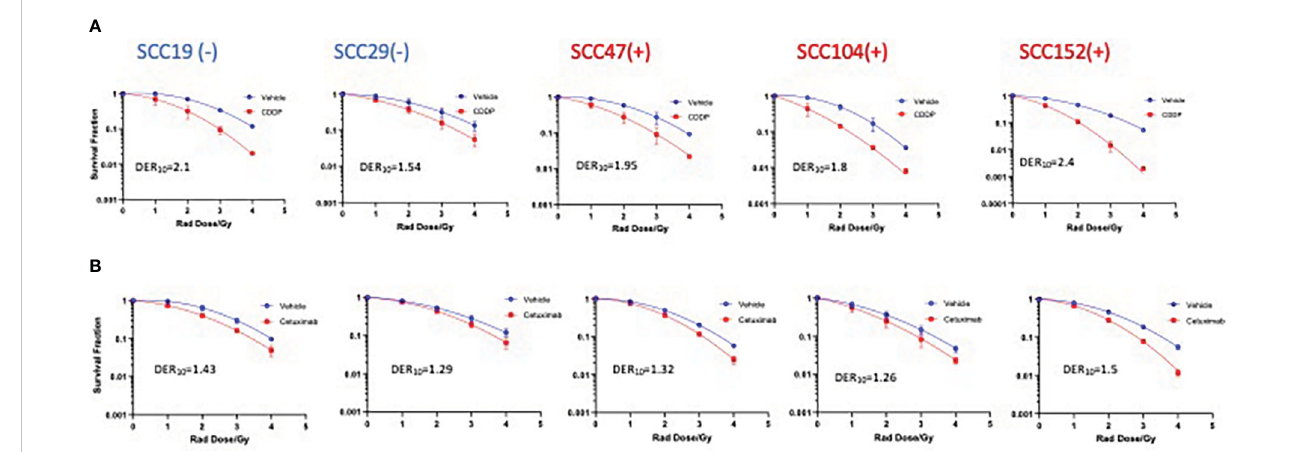
FIGURE 1 Sensitization of HNSCC cells to X-ray radiation combined with CDDP and Cetuximab. HPV - (-) and HPV + (+) cells were treated with either CDDP or cetuximab (see Table S1 for concentrations) in combination with radiation (0-4Gy)). Colonies were counted after 14-21 days of incubation and normalized to controls. Survival analysis was performed using the linear quadratic model and GraphPad. Both CDDP (A) and cetuximab (B) show sensitization in all cell lines regardless of HPV status. Values shown represent means ± standard deviation from 3 independent